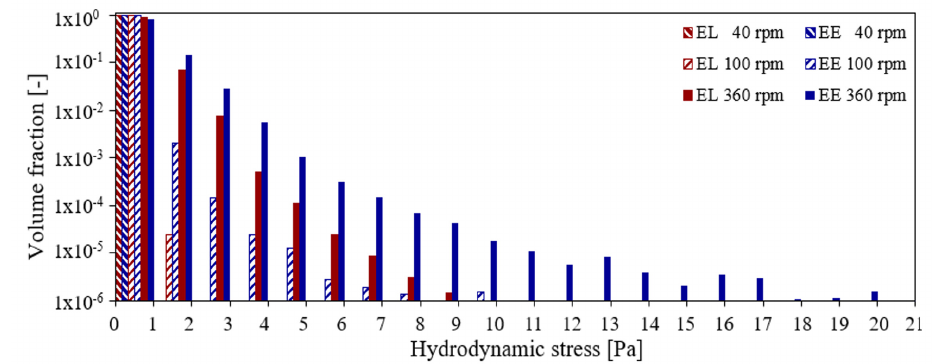
Figure 8. Liquid volume fraction distribution of the hydrodynamic stress regions for conditions 7, 4, and 8 for the EL and the EE